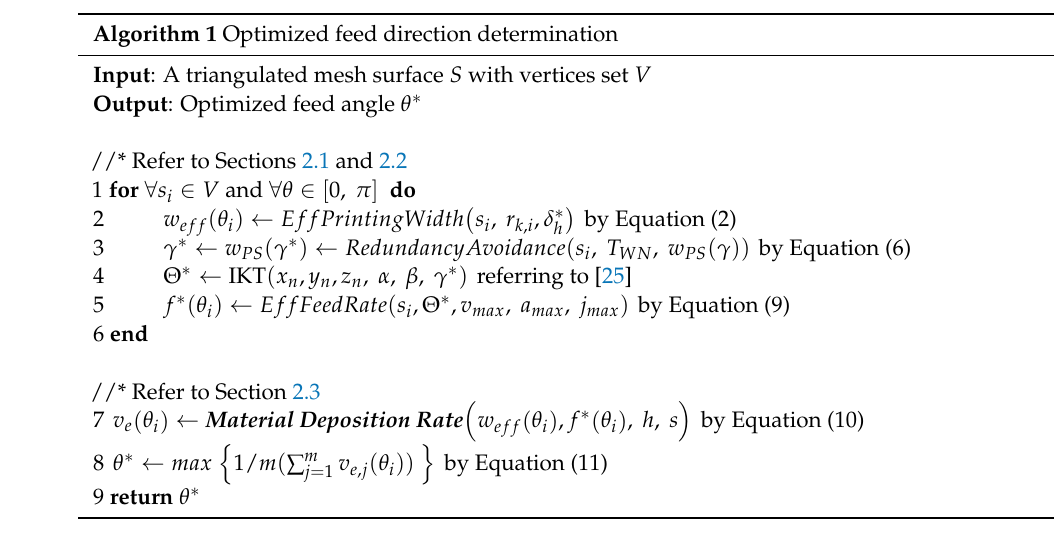
Algorithm 1 Optimized feed direction determination